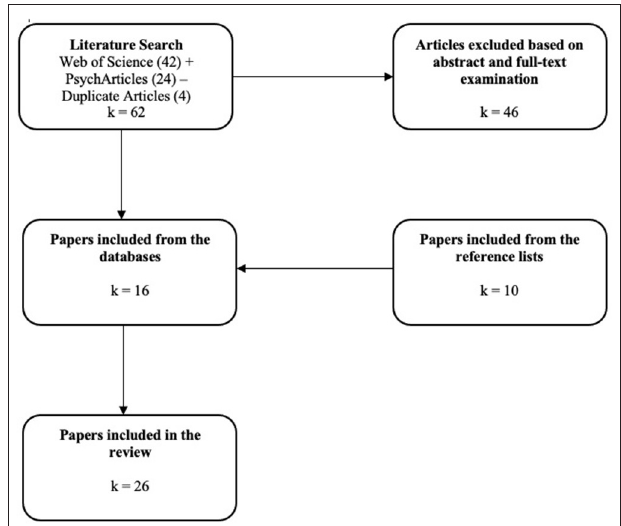
FIGURE 1 | Selection process of included